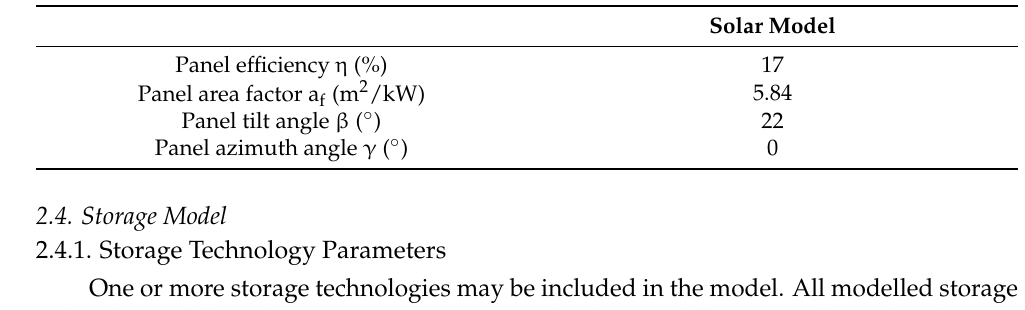
Table 3. Technology parameters used for Li-ion batteries in this study.